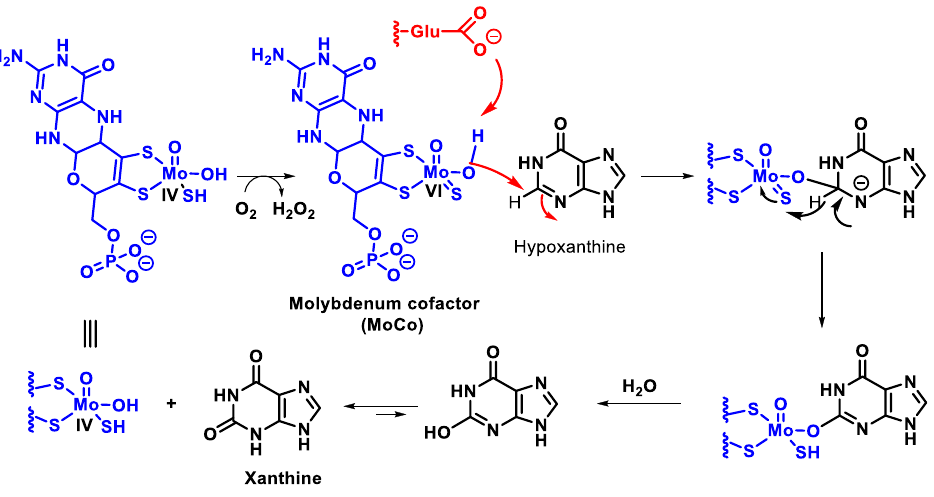
Figure 7. Mechanism of xanthine oxidase reaction. The mechanism by which XOR converts xanthine to uric acid is not fully understood, but it has been suggested that a reduction and oxidation reaction occurs, as shown in the figure, resulting in oxidative damage to tissues [28], Figure 8.